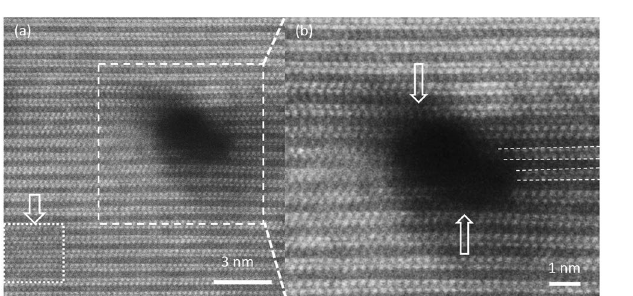
Figure 3. ( a ) Higher magnification image clearly showing the lattice distortion around the defect, where all the planes defined by Cr atoms tend to bend towards the defect. The area with structure changed by the electron beam is indicated by a rectangle. ( b ) Enlargement of the defect shown in ( a ). The lattice distortion can be observed at the positions along the direction of the upper and lower arrows. In addition, the Cr-Cr interplanar distance is shortened towards the defect, while the Cr-Al distances are elongated, as indicated with dashed